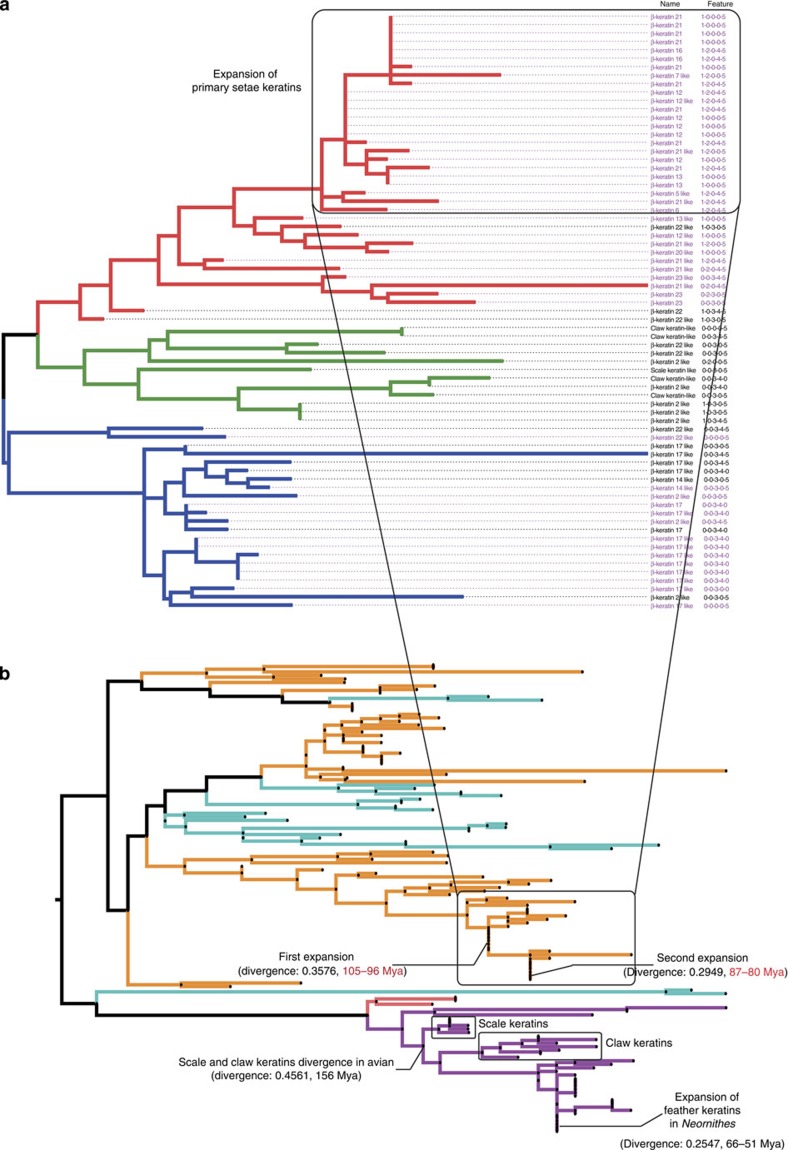
Evolutionary analysis of setae β-keratins.(a) Phylogenetic tree of β-keratins from G. japonicus. The red branches represent β-keratins belonging to the primary components of setae, the blue branches represent the components in pad lamella for supporting setae and the green branches represent β-keratins in scales or claws. A total of 48 β-keratins (purple font) are clustered in scaffold 426, of these 46 have a single exon. The combinatorial numbers following the keratin names indicate the following protein characteristics: 1: S-core box (SEVTIQPPPCTVVVPGPVLA, sequence similarity ≥70%, 35 proteins); 2: cysteine-rich (Cys >10%, 19 proteins); 3: glycine-rich (Gly >15%, 36 proteins); 4: isoelectric point (pI >7, 34 proteins); 5: molecular weight (Wt <15,000, 58 proteins); 0: none of the above. β-keratins associated with clinging ability have undergone extensive expansion and have higher isoelectric points. (b) Calculation of the expansion period for primary gecko setae β-keratins using protein sequences from 71 β-keratins of G. japonicas (orange), 23 β-keratins of An. carolinensis (light blue), 2 β-keratins of Al. sinensis and 1 β-keratin-like of Crocodylus niloticus (pink), and 36 β-keratins associated with bird's claw, scale and feather (violet, including the following birds: Gallus gallus, Chlamydotis macqueenii, Opisthocomus hoazin, Mesitornis unicolor, Haliaeetus leucocephalus, Leptosomus discolor, Nestor notabilis, Chaetura pelagica, Pterocles gutturalis, Tinamus guttatus, Pygoscelis adeliae, Tauraco erythrolophus, Manacus vitellinus, Picoides pubescens, Mycteria americana, Cathartes aura and Eurypyga helias). The divergence of scale and claw keratins occurs in a birds ancestor ∼156 Myr ago, and the feather keratins expansion occurred in birds ∼66 Myr ago. β-keratins in setae of G. japonicus have undergone two expansion periods: one approximately 105–96 Myr ago and the other approximately 87–80 Myr ago.